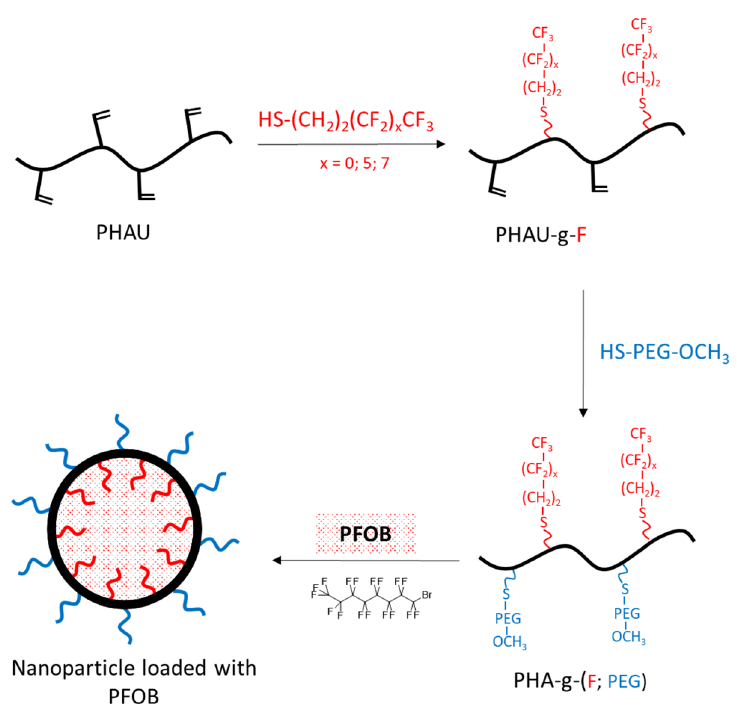
Figure 2. The synthetic route for the production of PFOB loaded nanocapsules. Table 1. Chemical structures of the different perfluorinated thiols.